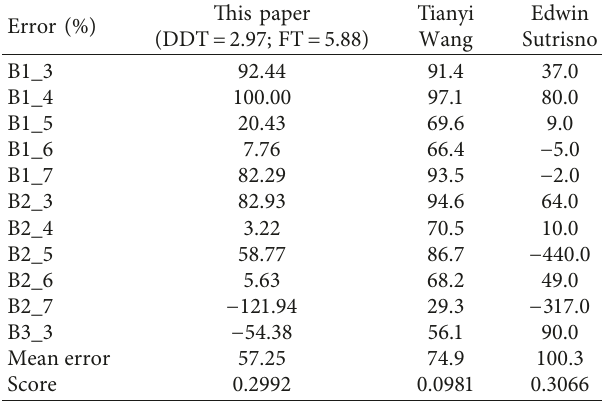
Table 1: Distribution and parameter estimation. Symbol Before bootstrap sampling After bootstrap sampling